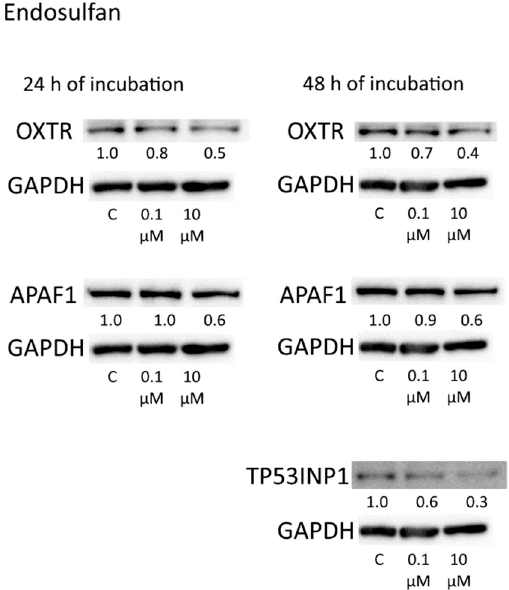
Figure 11. Western blot analysis of OXTR, APAF1, and TP53INP1 in cells incubated with endosulfan for 24 and 48 h. The numbers under bands denote fold change in the protein level as compared to the